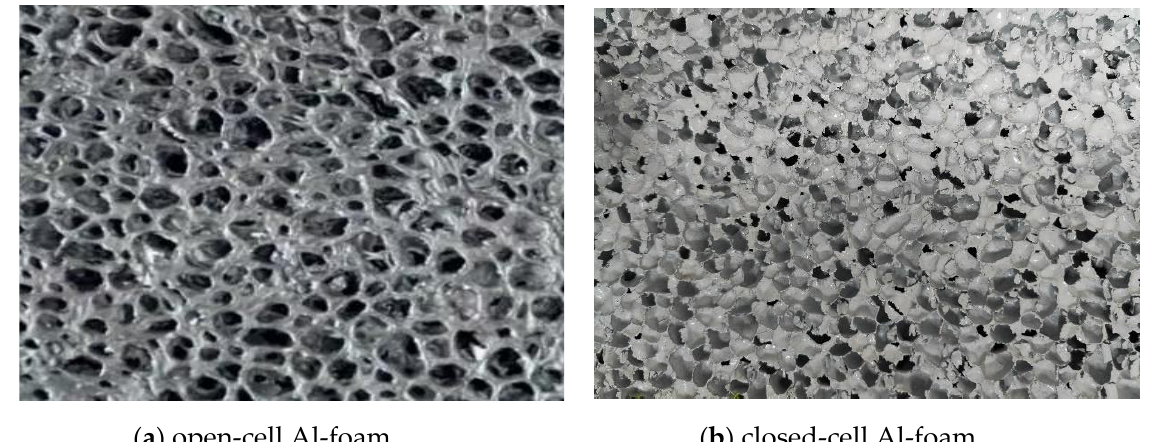
Figure 4. Aluminum foam sample diagram.